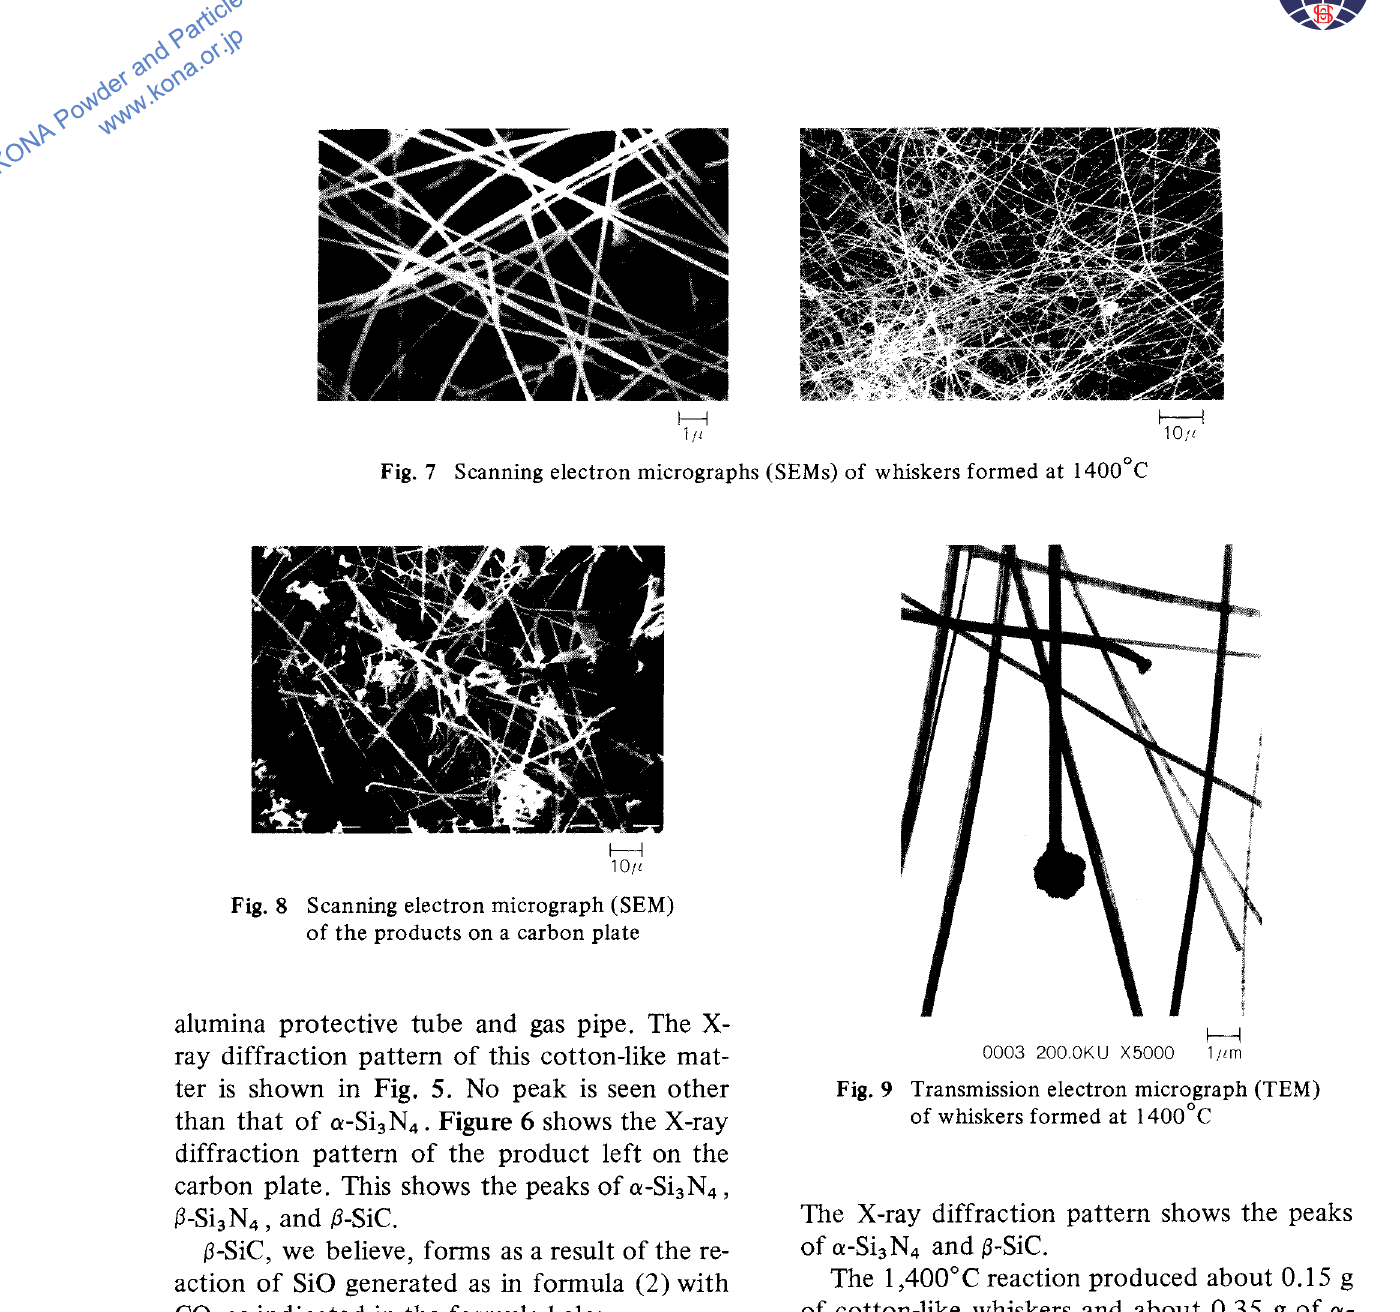
Fig. 9 Transmission electron micrograph